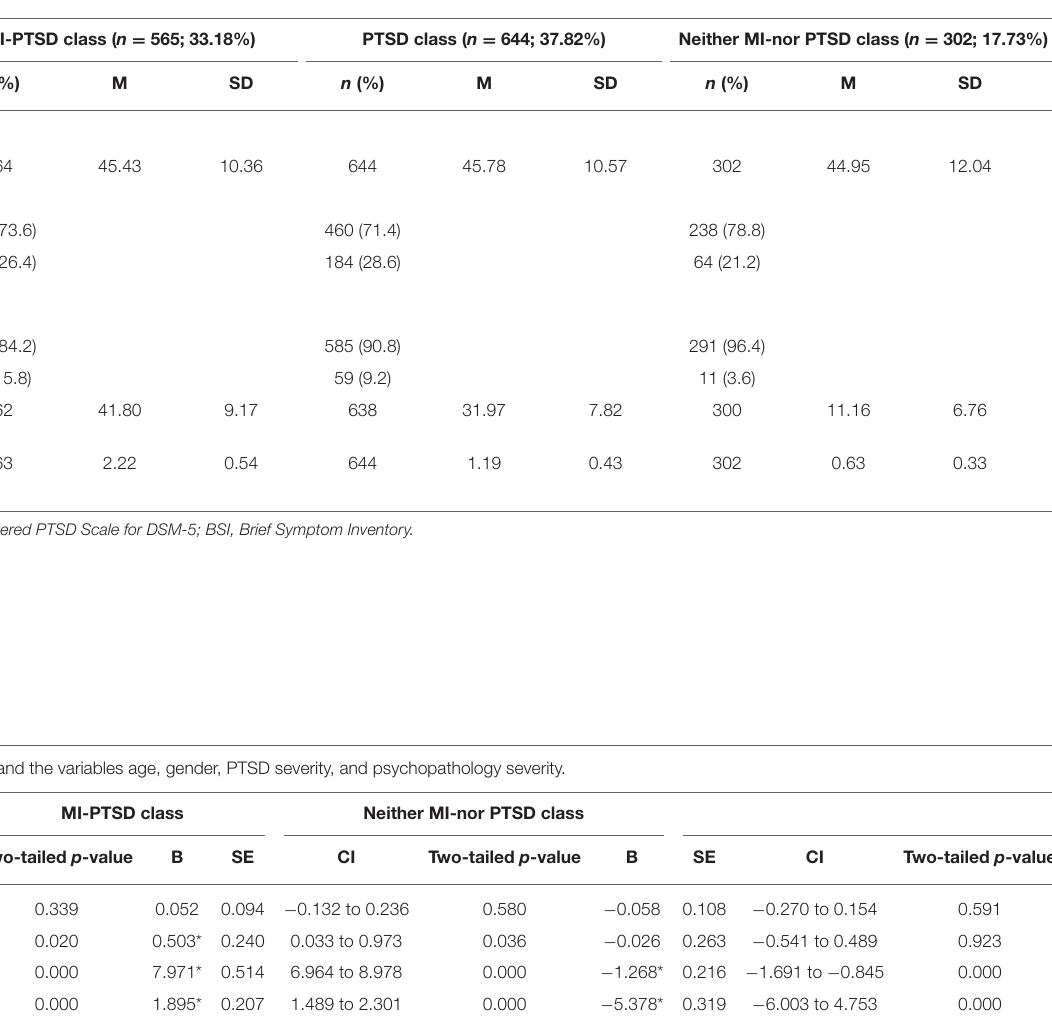
TABLE 4 | Descriptive statistics of the variables within the four-class solution.